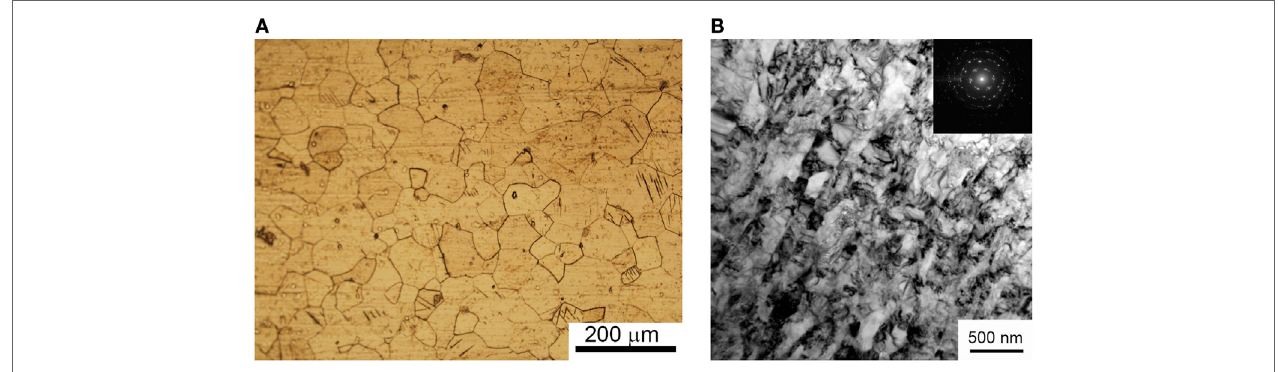
FigUre 1 | Micrograph from optical metallography microscope of coarse grain commercially pure Ti (a) and TEM image of ultrafine-grained Ti after severe plastic deformation (B)